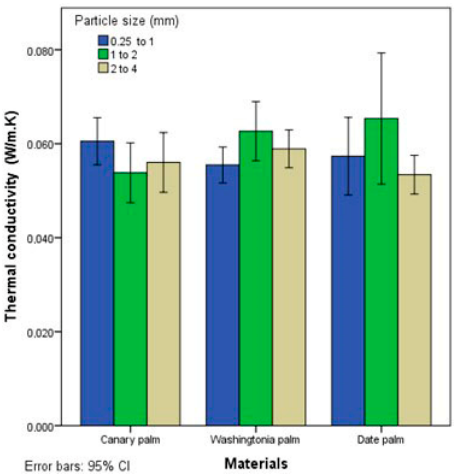
Figure 7. Average thermal conductivity results according to the palm species and particle size.